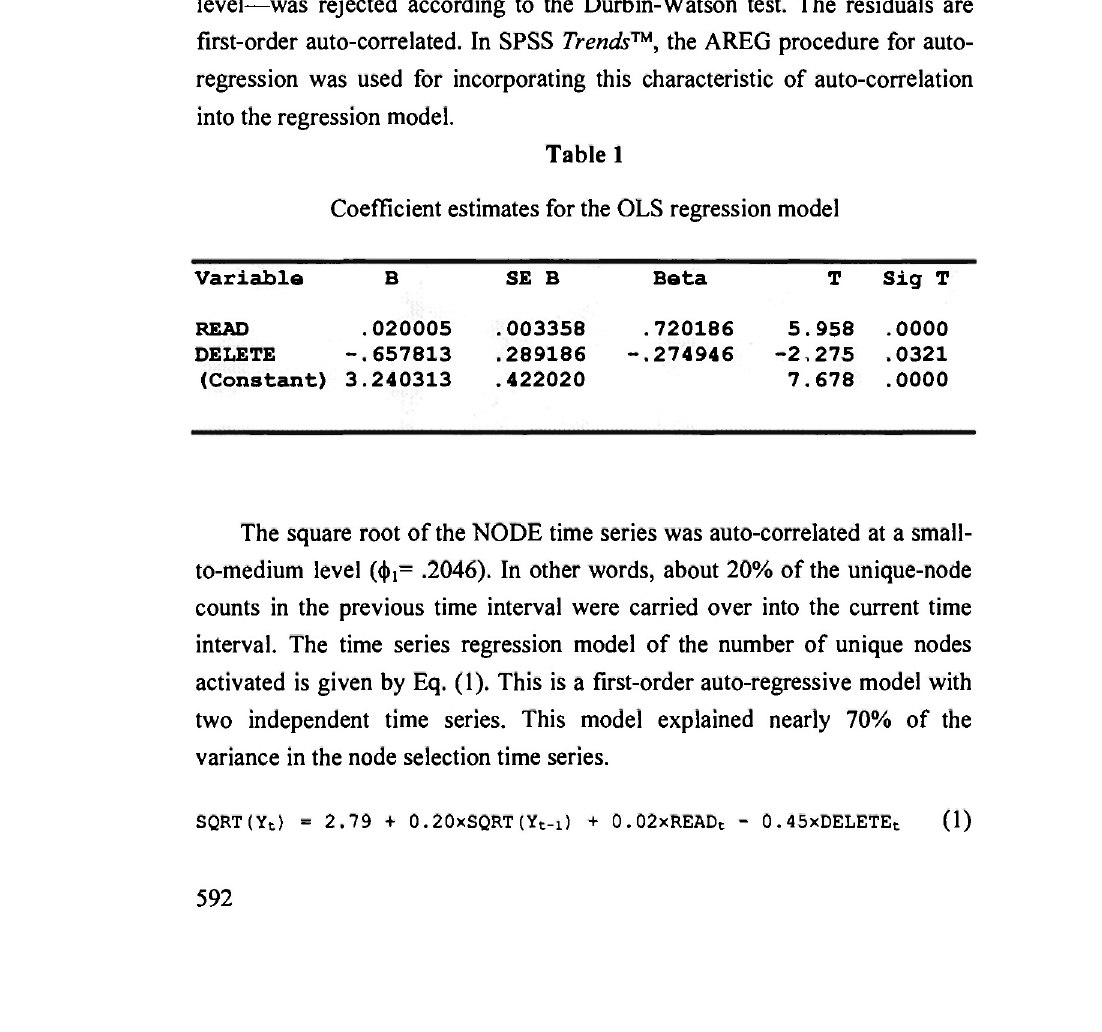
Coefficient estimates for the OLS regression